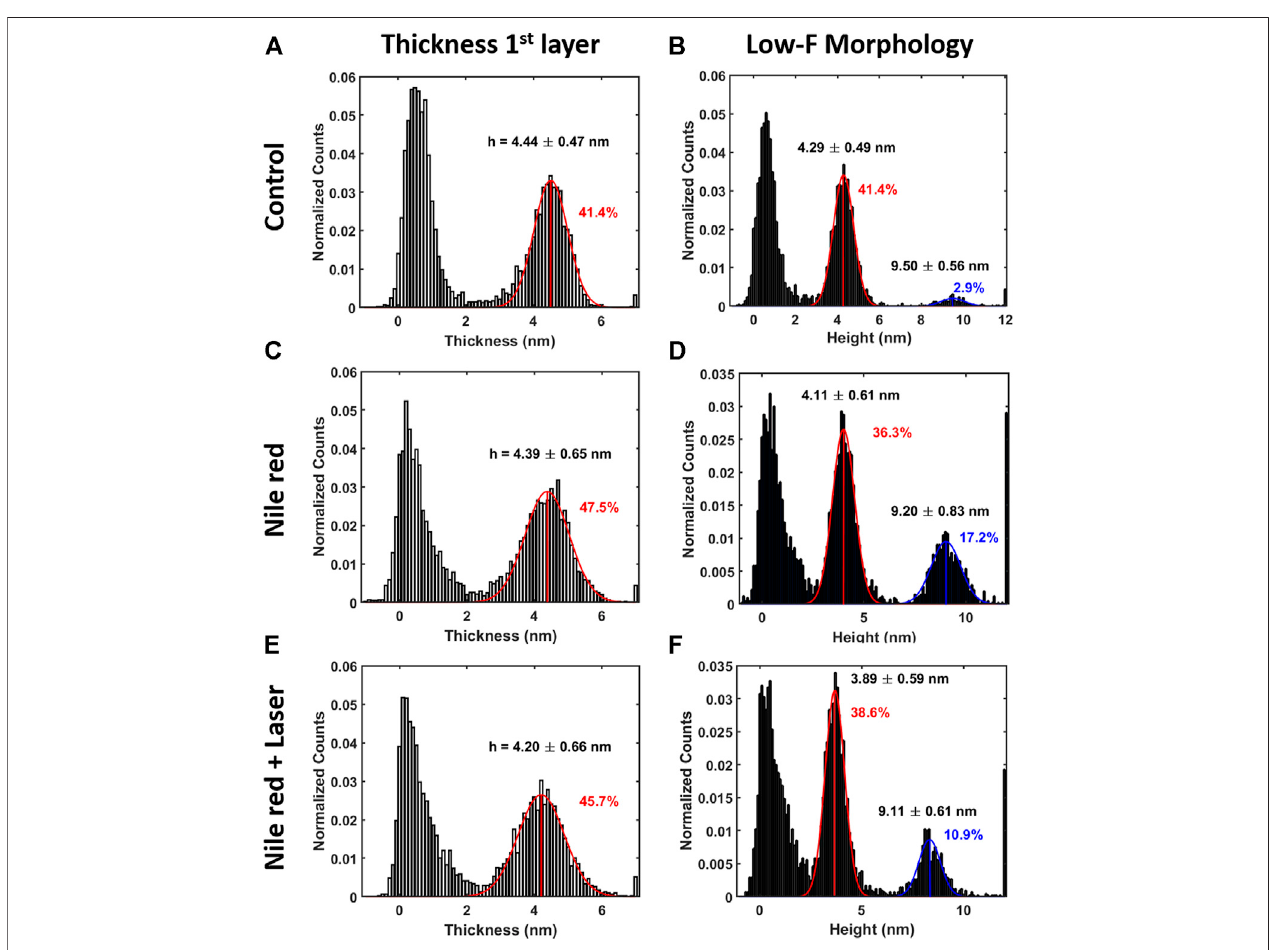
FIGURE5| Quanti fi cationwithhistogramsandGaussian fi trelativetomorphologicalanalysis. (A) Thicknesshistogramof fi rstlayerandsubstrate, (B) low-force(F < 0.3 nN) morphology histogram for control DOPC. Sameorder of histogram of DOPC after 30 min incubation with 2.5ug/ml Nile red with DMSO at 2.5% (C,D) , and after irradiating probe region with 35.4 mW/ μ m 2 laser (E,F) . Gaussian fi tting and average are depicted for fi rst (red color) and additional layers (blue color), while percentages are indicative of area coverage (events falling in under the fi t curve). Counts of vertical axis are normalized on total number of traces